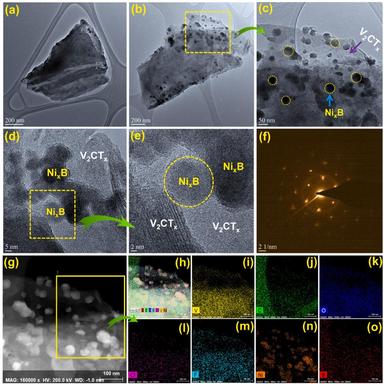
(a–e) TEM and HR-TEM images at low and high magnification, (f) SAED pattern, and (g–o) elemental mapping results of NixB/V2CTx composites.